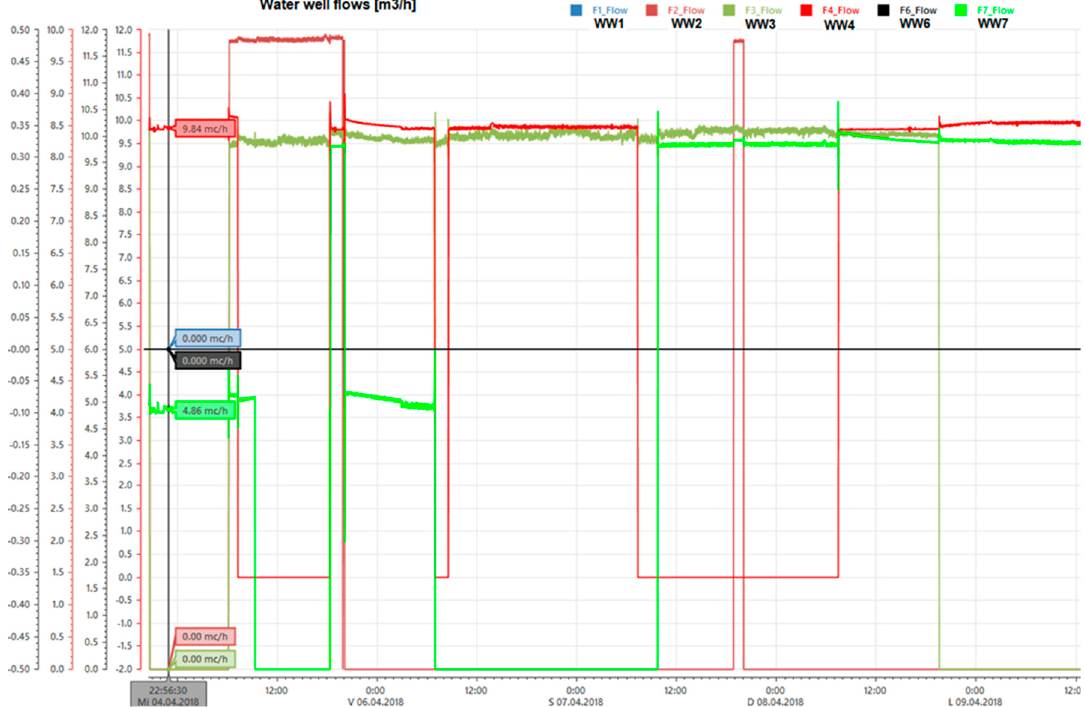
Figure 10. Water well (WW) output flows.